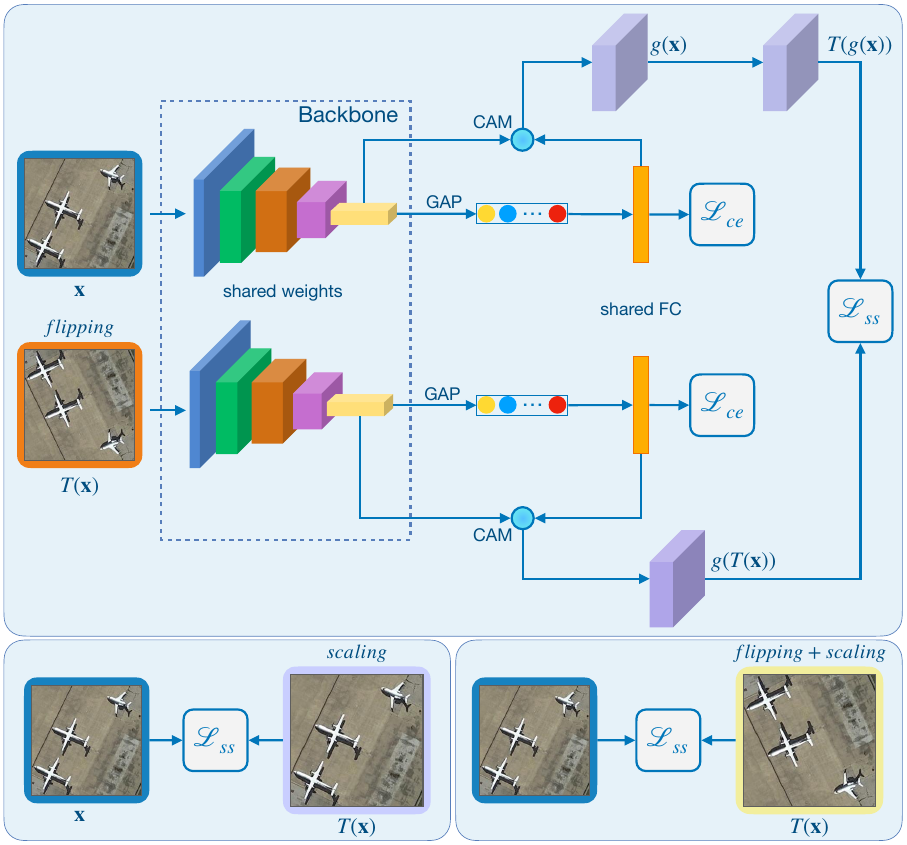
Figure 6. The proposed self-supervised network. We take the original-transformed image pairs as inputs and compute the Class Activation Maps (CAMs) for each input image. Then, we define a new self-supervised loss as a distance between the transformed CAMs of the original image and the CAMs of the transformed